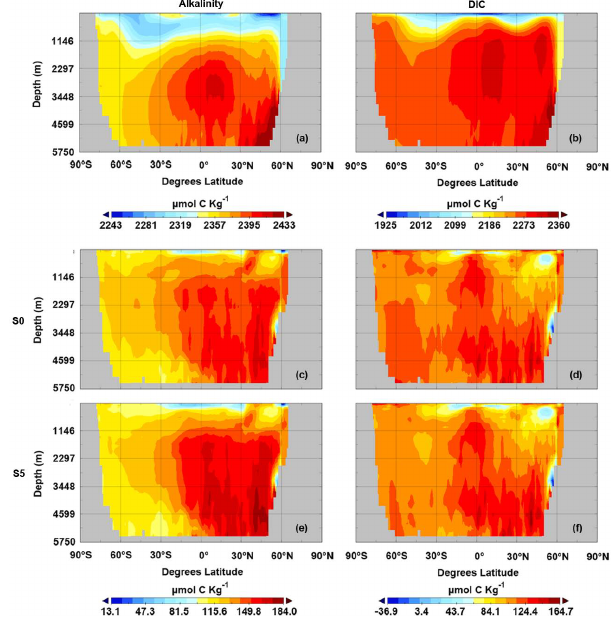
Fig. 4. Observed (a) ocean alkalinity and (b) dissolved inorganic carbon (Key et al., 2004). Panels (c) and (e) are plots of the differ- ence between the zonally averaged global ocean alkalinity model output in year 1995 and observations for runs S0 and S5 respec- tively. Panels (d) and (f) are plots of the difference between the zonally averaged global dissolved inorganic carbon model output in year 1995 and observations for runs S0 and S5 respectively.